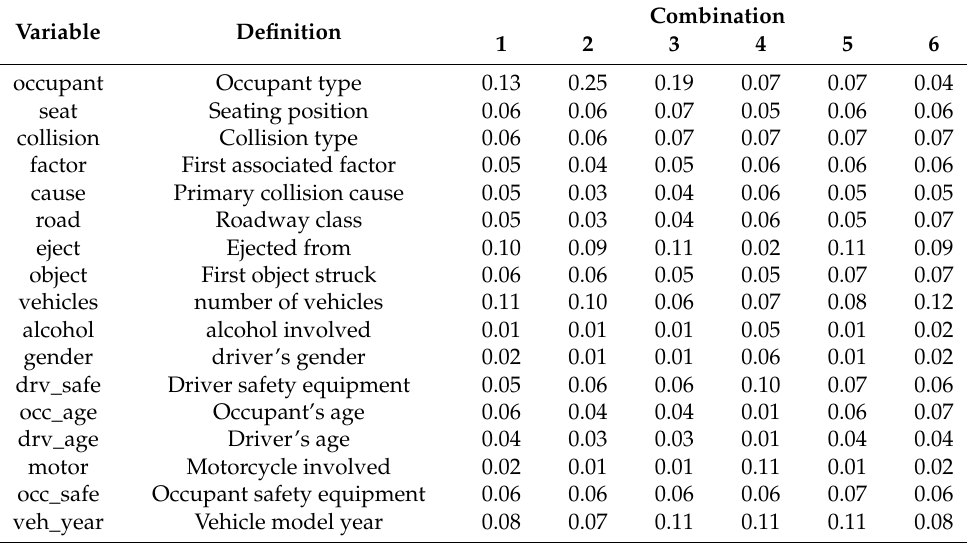
Table 5. Permutation feature importance for six combinations.